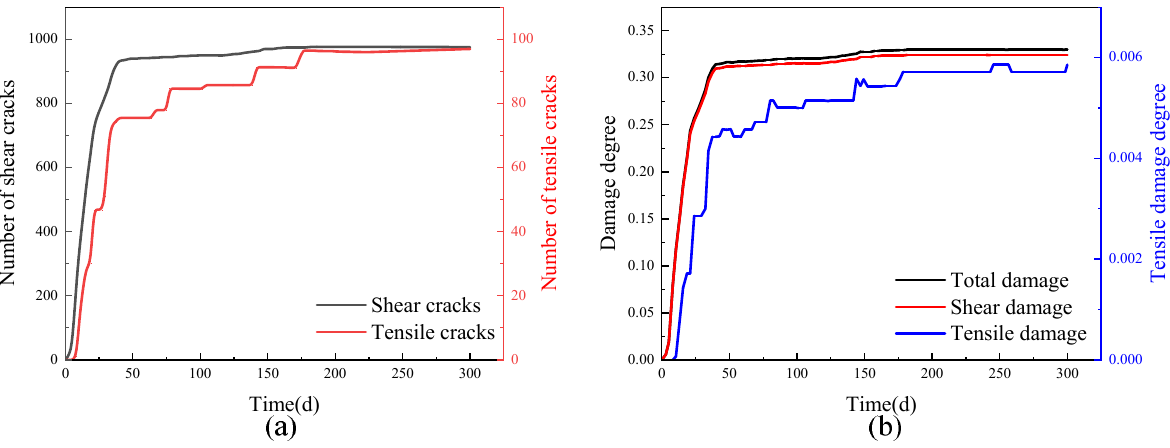
Figure 13. Comparison between on-site damage characteristics and simulated damage characteristics of the roadway. ( a ) simulated damage characteristics; ( b ) on-site damage characteristics.